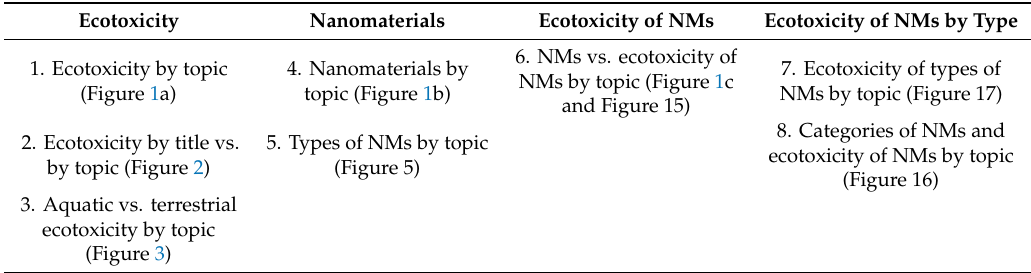
Table 1. Summary of bibliometric analysis of research on ecotoxicity of nanomaterials (NMs) from Web of Science Core Collection (Web of Science, Clarivate Analytics) presented in this